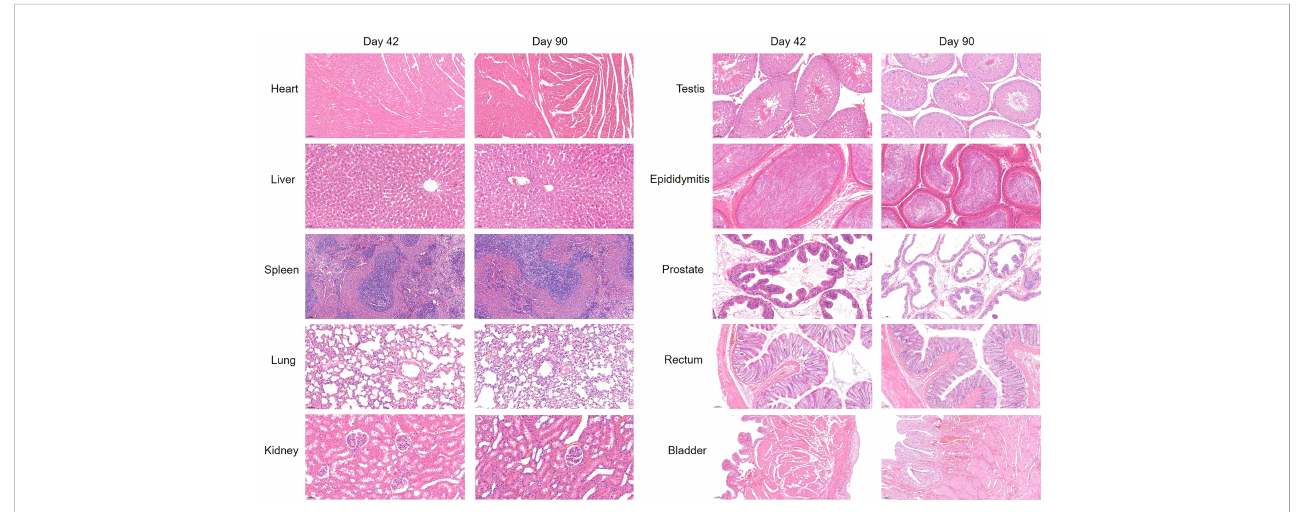
FIGURE 6 H & E-stained images of the heart, lung, liver, kidney, spleen, testis, epididymis, and hydrogel-adjacent rectal, prostate, and bladder tissues at day 42 and day